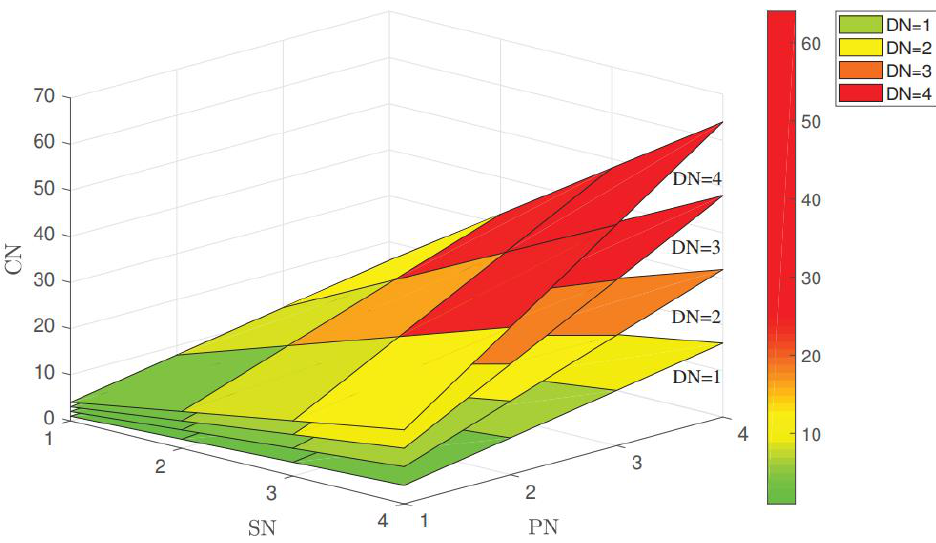
Figure 4. Criticality number (CN) matrix with applied limits.